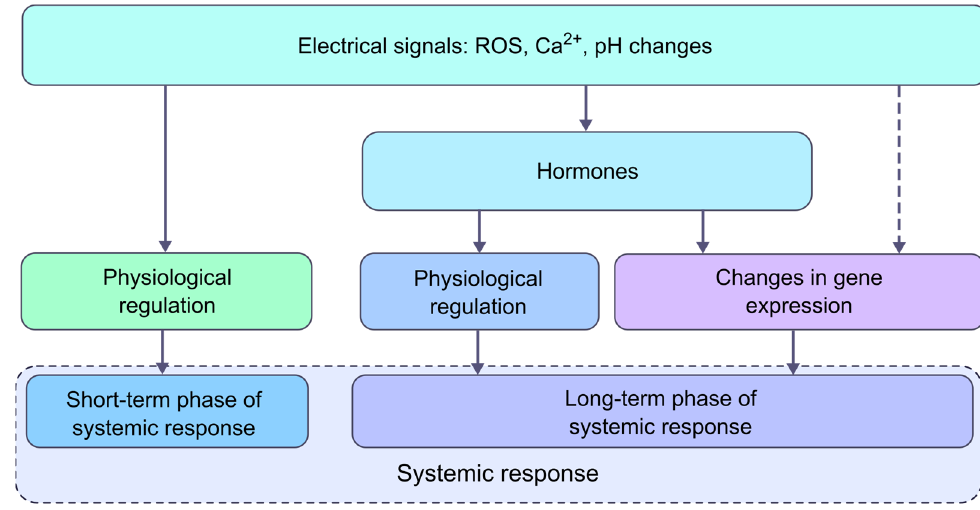
Figure 4. Model for the formation of two-phase systemic response. The propagation of electrical signals induces a short-term phase of the systemic response and changes in hormone content in the systemic tissues of plants. The short-term phase of the systemic response is controlled by so-called physiological regulation, which directly affects physiological processes mediated by changes in pH, Ca 2+ and ROS levels. The long-term phase of the systemic response is controlled by hormones through physiological regulation and changes in gene expression, which can also be affected by electrical signals.